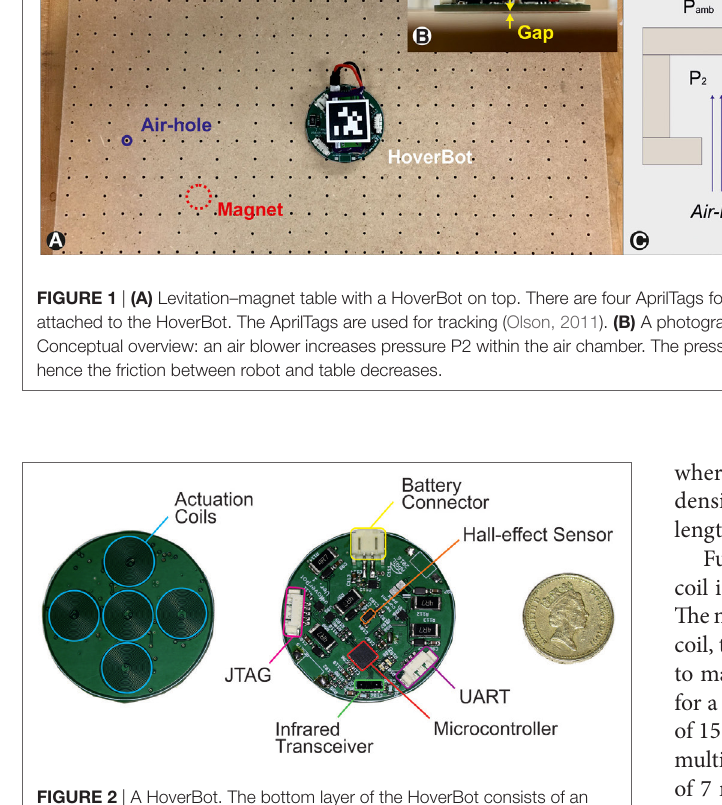
FigUre 2 | A HoverBot. The bottom layer of the HoverBot consists of an array of five planar actuation coils. Its top layer is populated with Hall-effect and infrared sensors and a low-power (SAMD21E) microcontroller. The battery of a HoverBot is detached in this figure.